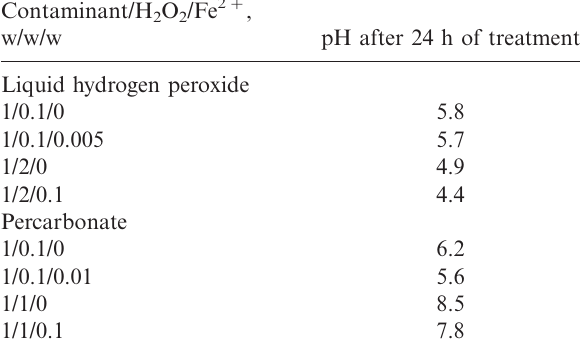
Table 3. pH values of the soil slurry after 24 h of treatment with liquid hydrogen peroxide and percarbonate, with and without a supplemental ferrous